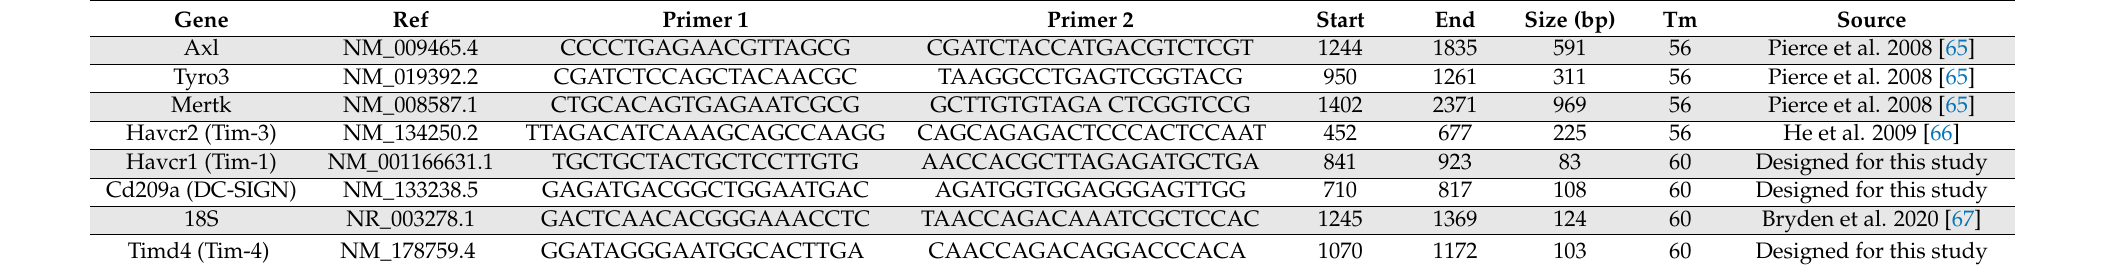
Table A1. Primer sequences used to determine expression of putative ZIKV